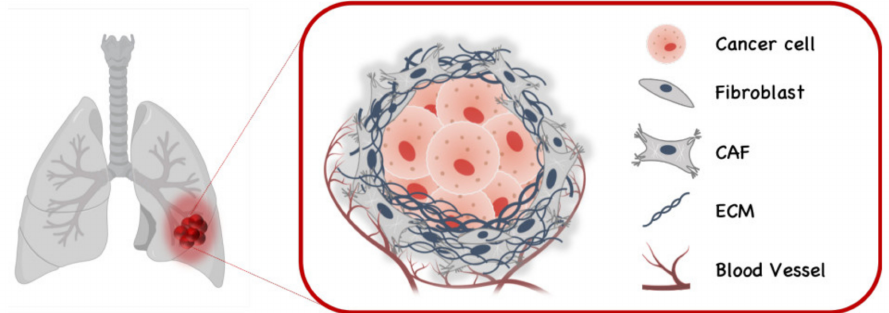
Figure 3. Cancer associated fibroblasts (CAFs) in lung